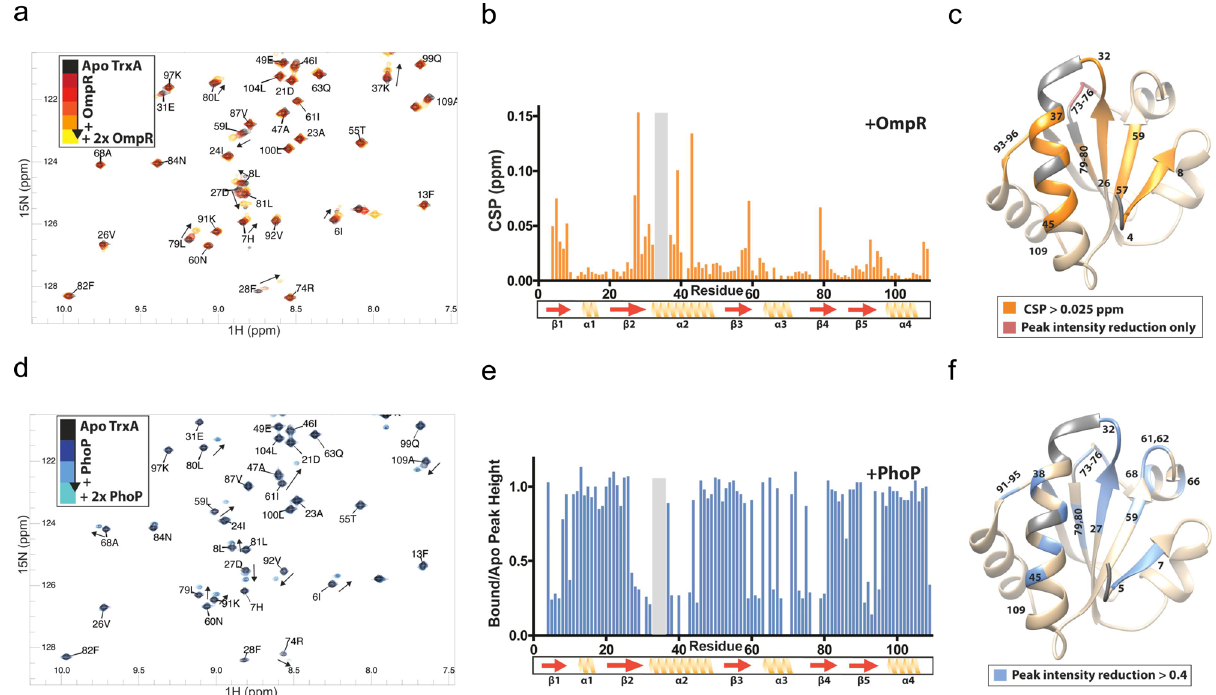
Fig. 2 | The TrxA binding interface is shared between OmpR and PhoP. a and d Overlay of 15 N-HSQC spectra of apo TrxA (black) with increasing amounts of either unlabeled OmpR (yellow, a ) or PhoP (blue, d ). The 15 N-HSQC spectra show peaksthatcorrelatechemicalshiftsofcovalentlybonded 1 Hand 15 Natomsonthe x- and y-axes, respectively. b Chemical shift differences between apo TrxA and TrxA:OmpR complexes (1:2 ratio), indicative of immediate chemical environ- ment change, i.e., protein-protein interaction. e Relative peak intensity